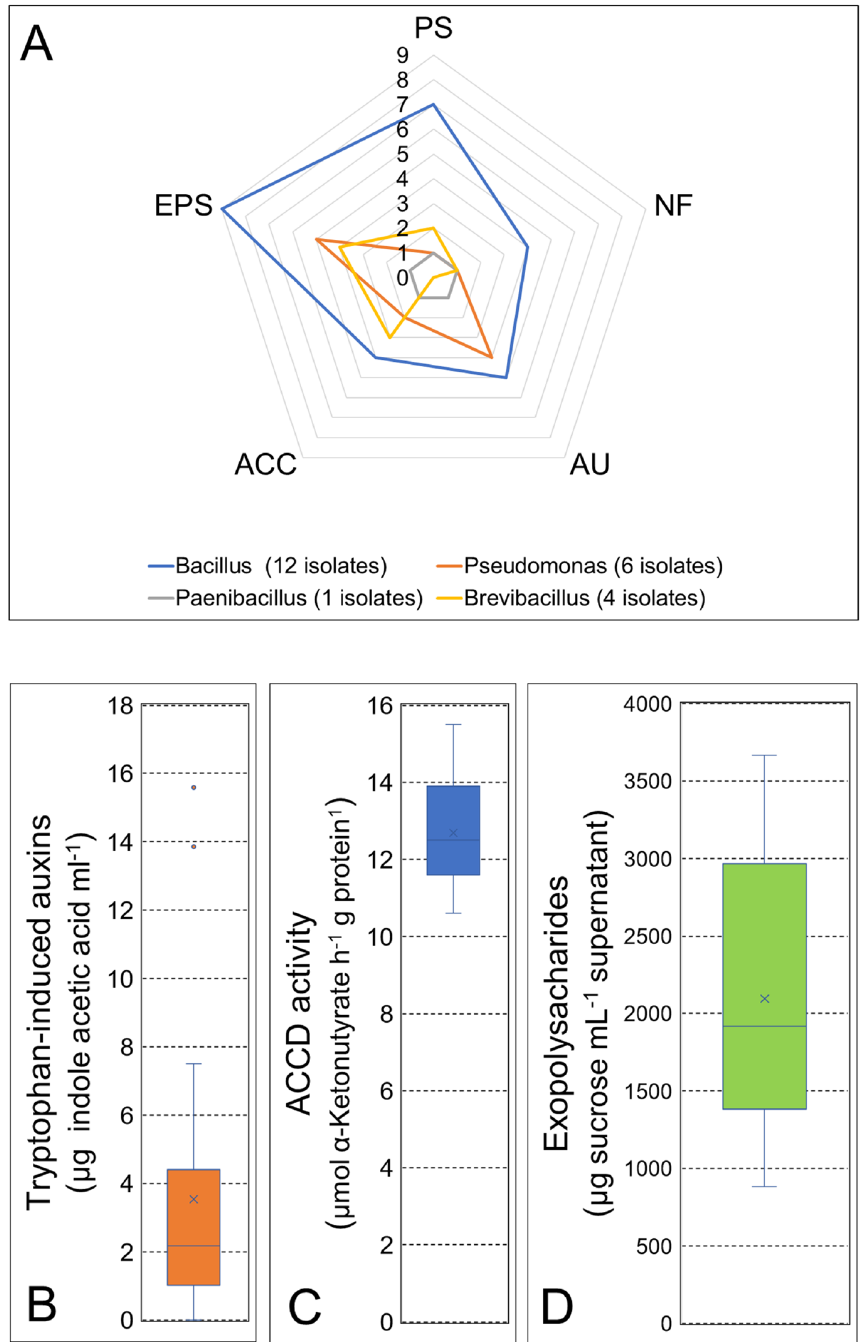
Figure 3. ( A ) Radial diagram showing the number of plant growth-promoting traits found in rhizobacterial strains isolated from Cistanthe longiscapa . PS phosphate solubilization, NF growth in N-free culture médium, AU production of tryptophan ‒ induced auxins ( B ); ACCD 1-aminocyclopropane-1-carboxylate deaminase activity ( C ); and EPS exopolysaccharide production ( D